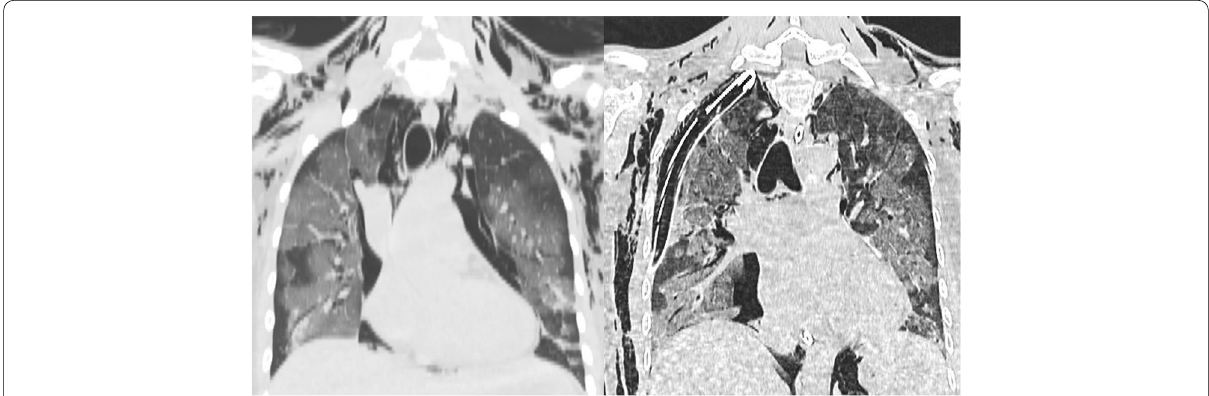
Fig. 3 Coronal chest computed tomography images of a 30-year-old female with COVID-19-related bilateral interstitial pneumonia, right pneumothorax, pneumomediastinum, and subcutaneous emphysema before (left) and after (right) chest tube